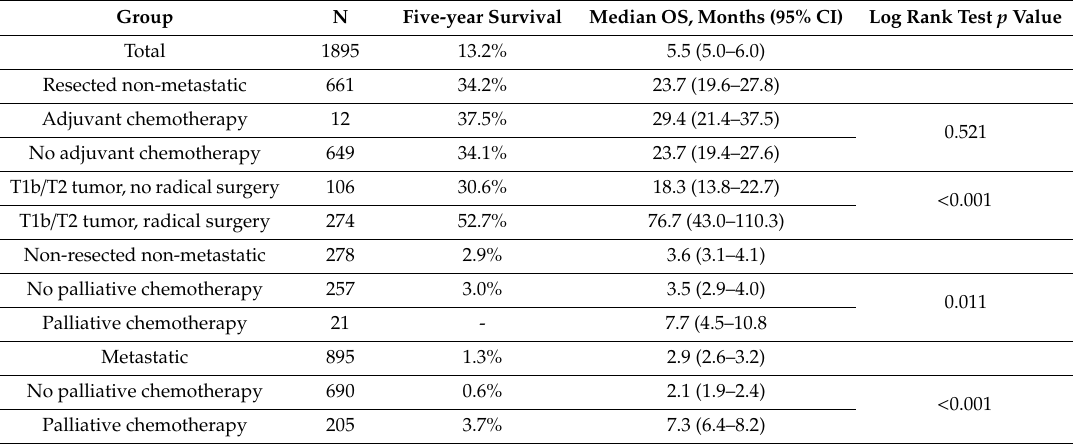
Table 2. Survival of patients with gallbladder cancer according to clinical stage and treatment strategy.